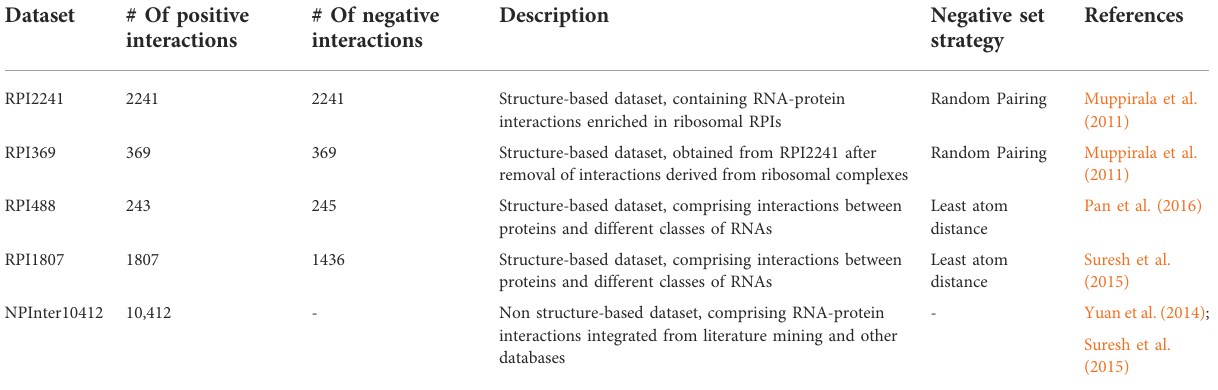
TABLE 4 Publicly available datasets for RNA-protein interaction prediction.